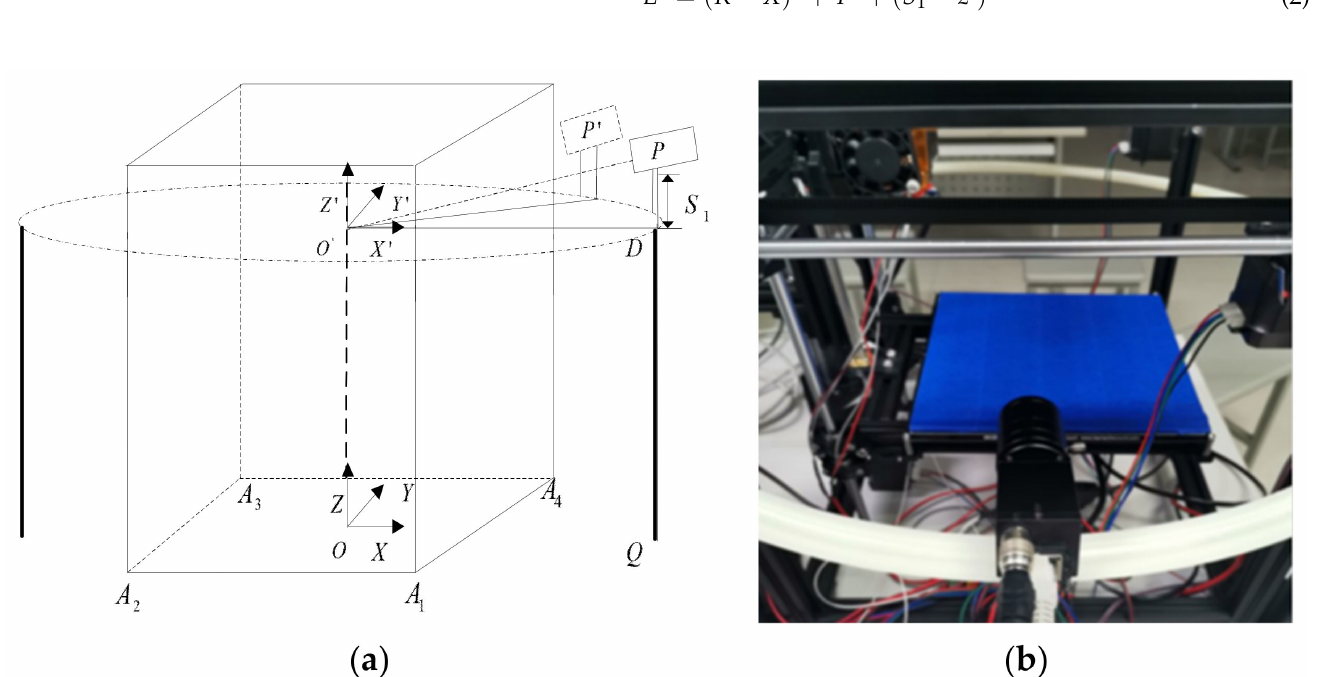
Figure 1. Structure and device of visual inspection system for 3D printing process: ( a ) structure of detection system; and ( b ) visual detection